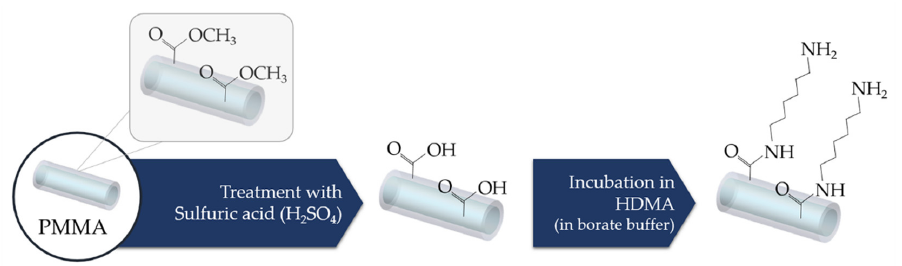
Figure 9. Schematic representation of a POF surface modification to produce an amine-terminated surface.